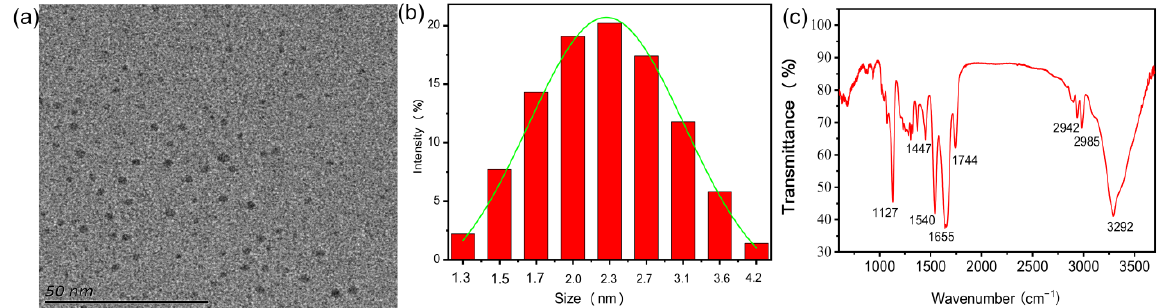
Figure 1. ( a ) HRTEM images of N-CQDs, ( b ) Histogram of N-CQDs size distribution, ( c ) FTIR spectrum of N-CQDs.